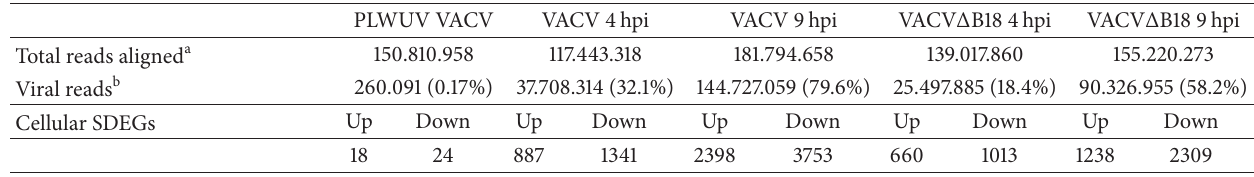
Table 1: Alignment of Illumina reads and number of differentially expressed genes from infected cells with the indicated viruses.